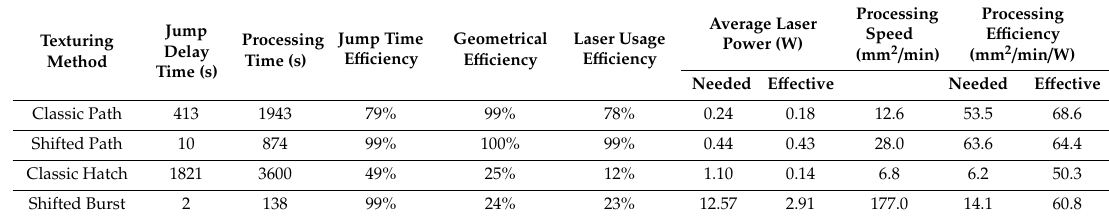
Table 2. E ffi ciency and processing speed for di ff erent texturing methods on a large processing area (2.4 × 170 mm 2 ). Processing times and speeds predicted by